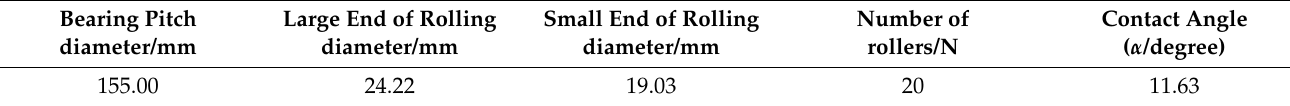
Table 2. High-speed shaft bearing parameters.